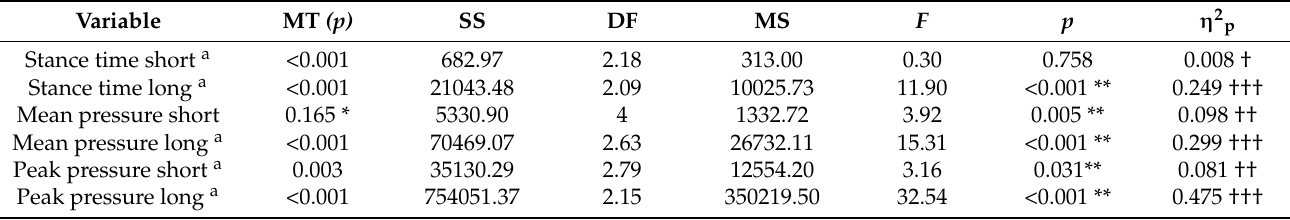
Table 4. Repeated-measures analysis of variance (RM-ANOVA) including a test of influence of the sphericity assumption, analysis of effect, and a contrast analysis of the significant interaction effect.